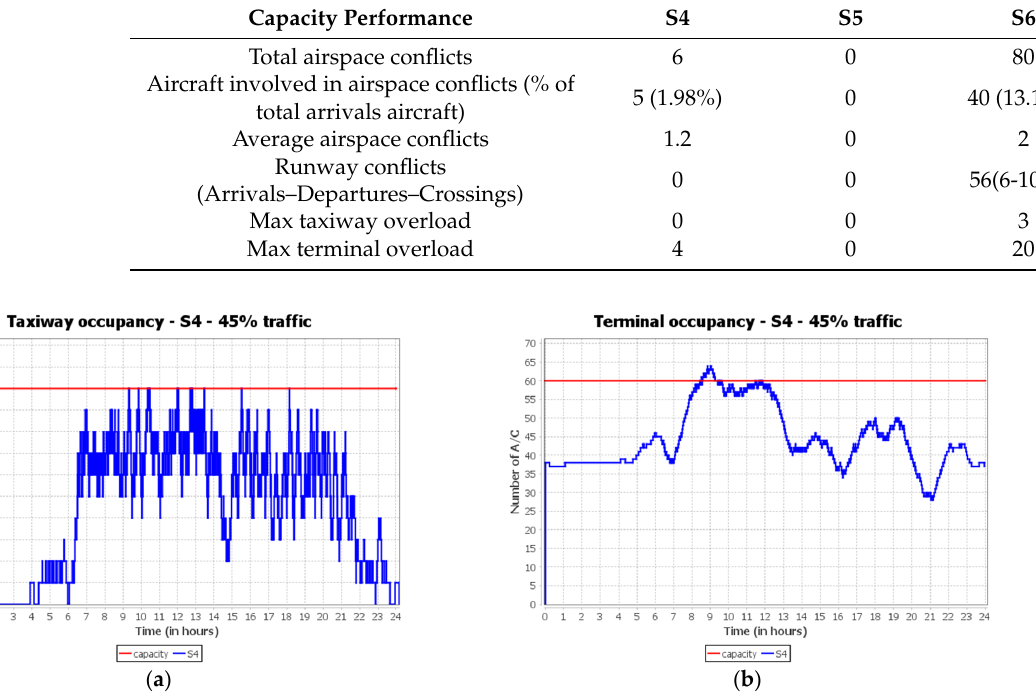
( b ) Figure 11. Taxiway ( a ) and terminal ( b ) occupancy scenario S6. The results of the ATM performance, displayed in Table 10, show that the delay in the airspace on average is higher in S6 than in S4 and S5, thus the optimization must tweak this decision variable more to find a suboptimal possible solution. This is given by the fact